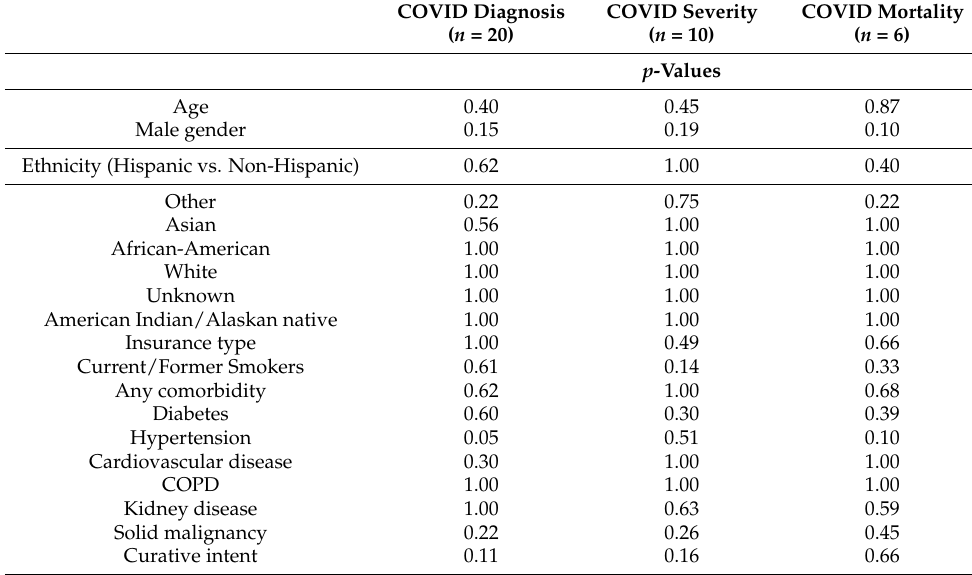
Table 2. Associated demographic and clinical factors with COVID positivity, severity, and